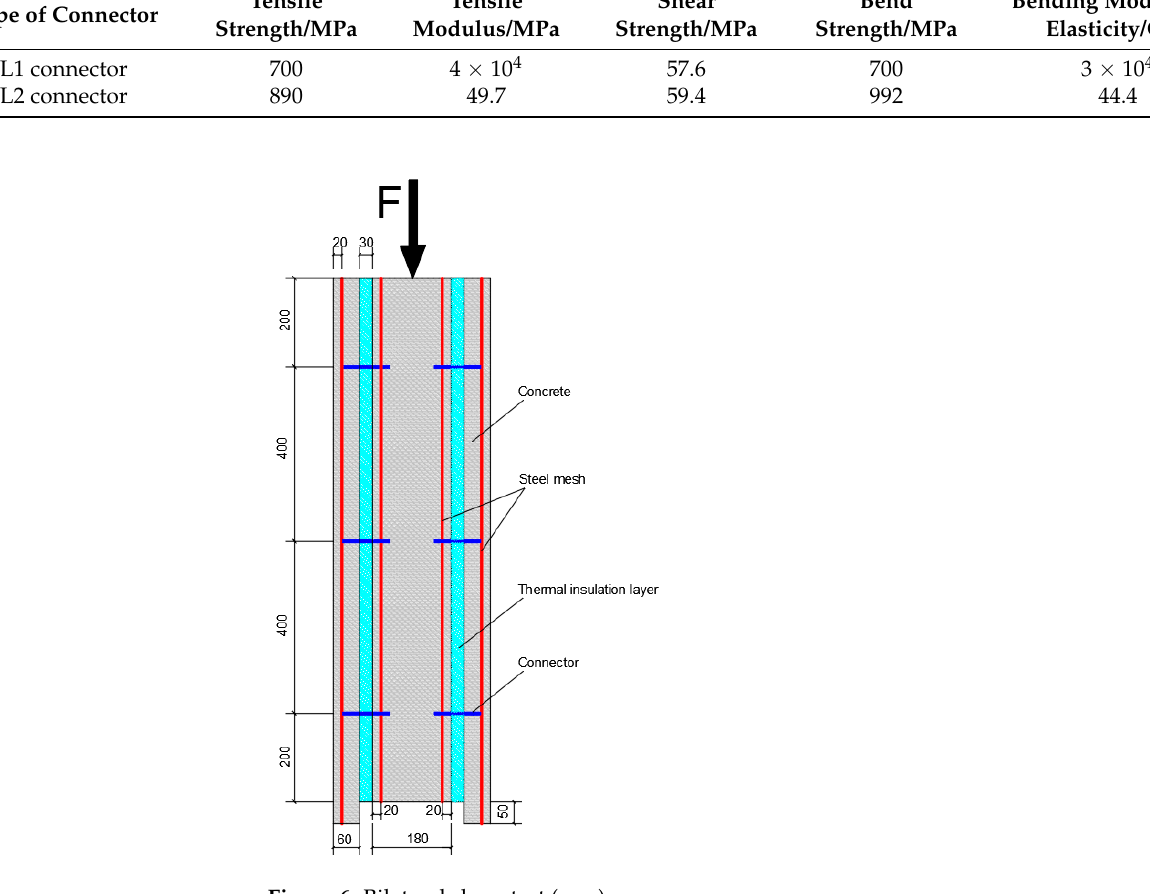
Figure 6. Bilateral shear test (mm).